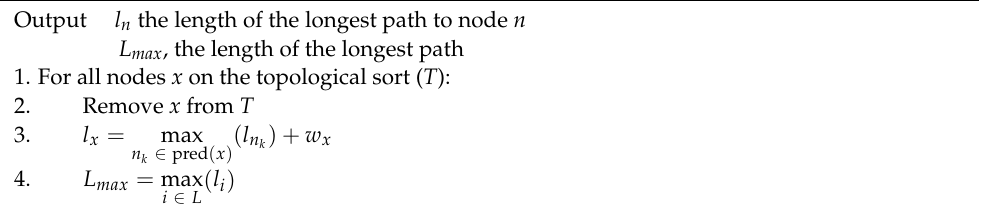
Algorithm 3: Finding the length of the longest path using Dynamic Programing